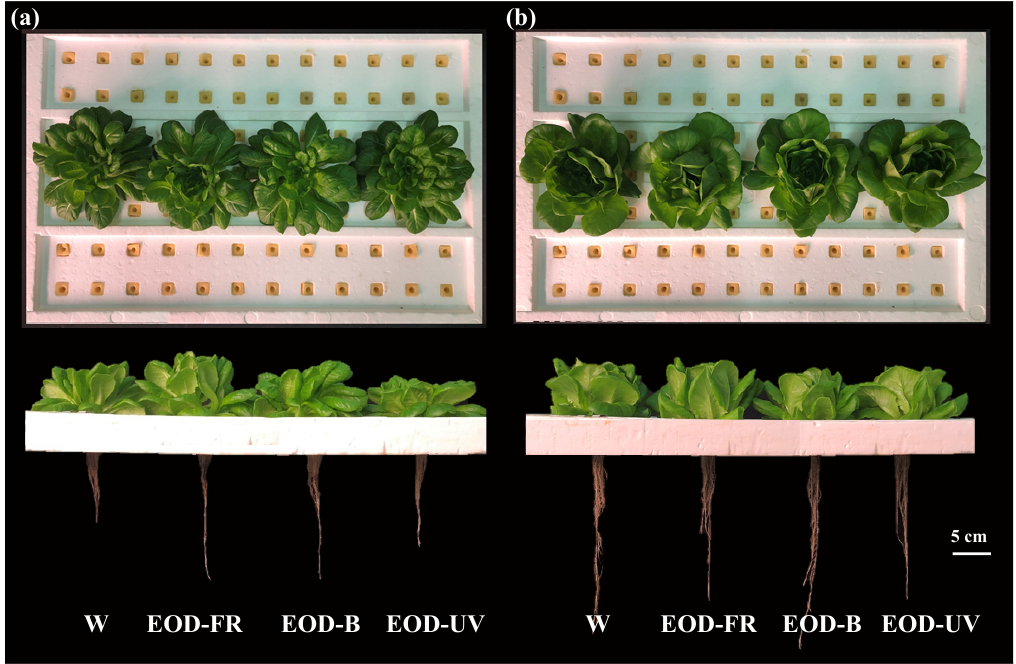
Figure 2. Lettuce morphology 24 days after treatments. ( a ) ‘Red butter’ and ( b ) ‘Green butter’ grown under di ff erent lighting treatments. W = day-white light, EOD-B = end-of-day enhanced blue light, EOD-FR = end-of-day far-red light, EOD-UV = end-of-day ultraviolet-A